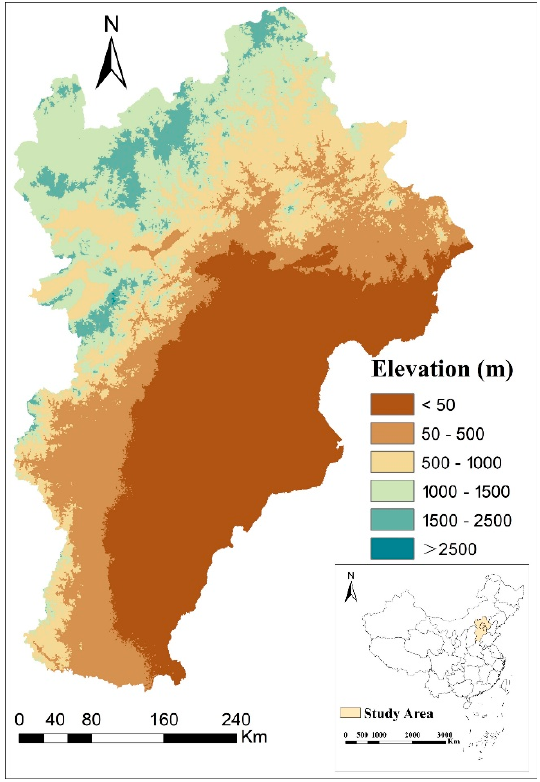
Figure 2. The Beijing-Tianjin-Hebei region.